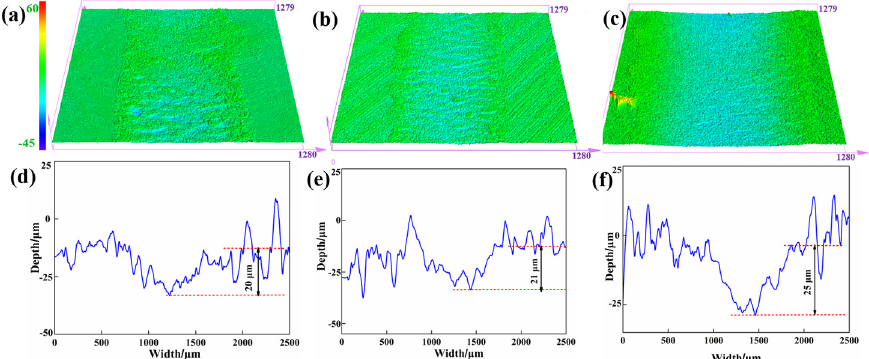
Figure 10. Three − dimensional morphologies of the worn surface of FGr@MoS 2 -1.2 at ( a ) 23 °C, ( b ) Figure 10. Three–dimensional morphologies of the worn surface of FGr@MoS 2 -1.2 at ( a ) 23 ◦ C, 40 °C, and ( c ) 60 °C. Wear track profiles of MoS 2 -1.2 at ( d ) 23 °C, ( e ) 40 °C, and ( f ) 60 °C. ( b ) 40 ◦ C, and ( c ) 60 ◦ C. Wear track profiles of MoS 2 -1.2 at ( d ) 23 ◦ C, ( e ) 40 ◦ C, and ( f ) 60 ◦ C.